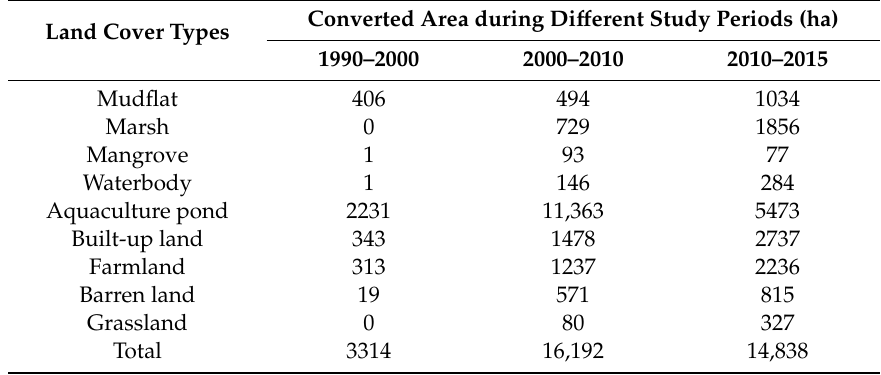
Table 4. Converted areas of S. alterniflora to various land cover types during the di ff erent study